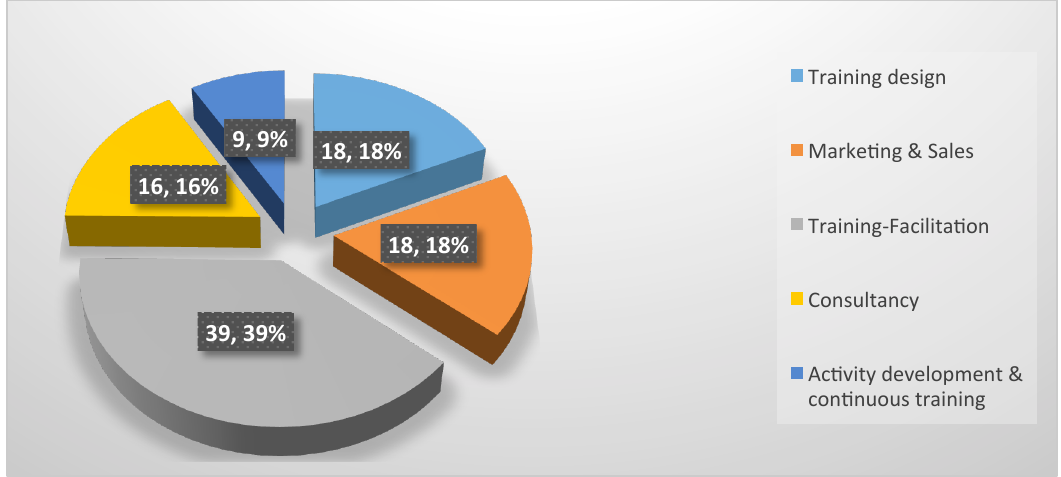
Figure 2 : Representation of average time devoted to the different activities in % Based on these data, it is possible to identify that the ‘core of work’ consists of the activity of training (about 40 % time devoted), to which functions of design and consultancy are aggregated (for about the same time), as well as an important part of marketing and administration activities (about 18 %). The ‘development of own activity and continuous education and training’ part remains the most limited, or perhaps the most